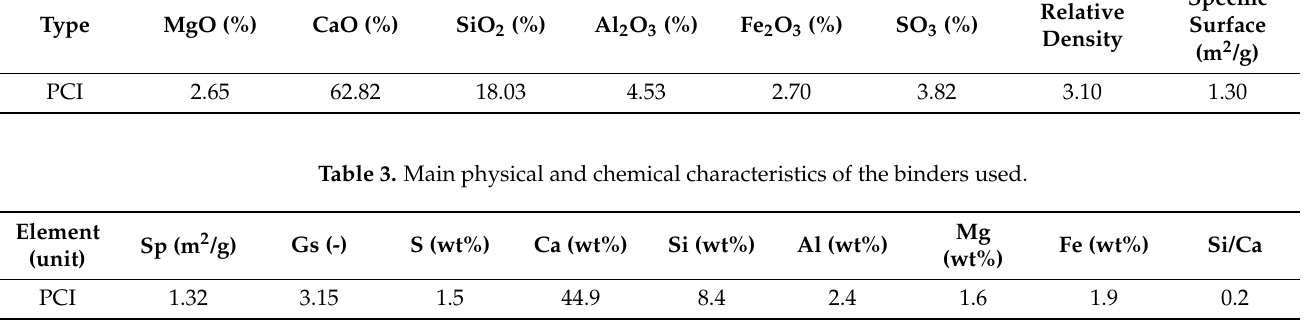
Table 2. Main chemical composition of the binders used for CTB preparation.